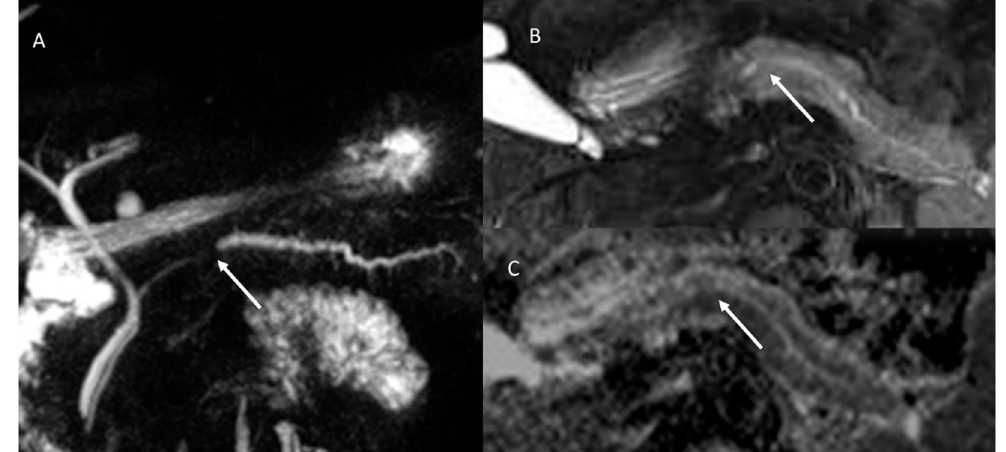
Figure 2. MR/MRCP assessment of Peutz–Jeghers syndrome patient. In MRCP ( A ), the arrow shows black sign and the dilatation of the main and secondary branch ducts. In T2-W sequences the ( B ) arrow shows hyperintense tissue and in ADC map ( C ) hypointense tissue.